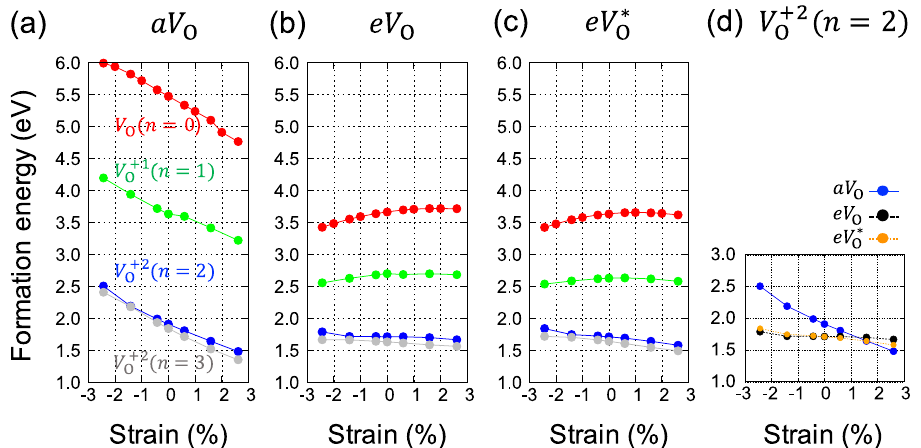
Figure 2. Oxygen vacancy formation energy ( E V ) in La 32−n Sr n Cu 16 O 63 under the strain from -2.43% to 2.61%. Red, green, blue, and gray colors correspond to n = 0, 1, 2, and, 3, respectively. Note that maximum oxidation number of oxygen vacancy is + 2. E V ’s of ( a ) apical and ( b ), ( c ) two inequivalent equatorial sites indicated in Fig. 1(c) are plotted. ( d ) E V ’s of + 2 charged vacancies ( n = 2) are plotted for the